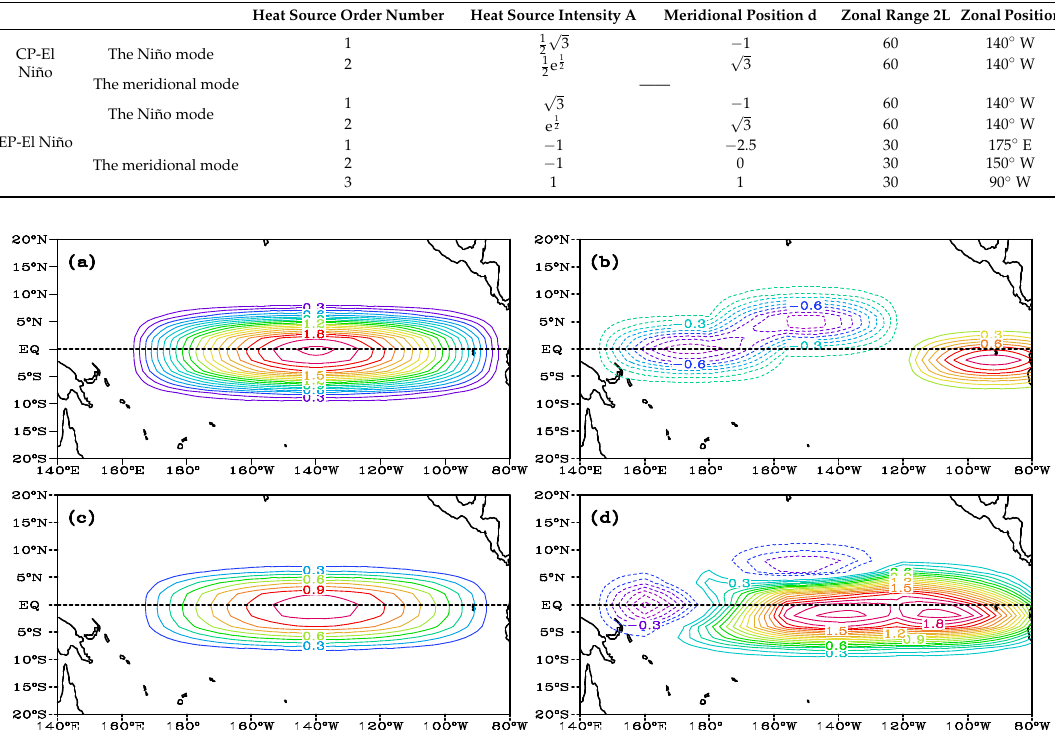
Table 4. Parameter setting for the heat source distribution of two types of El Niño.